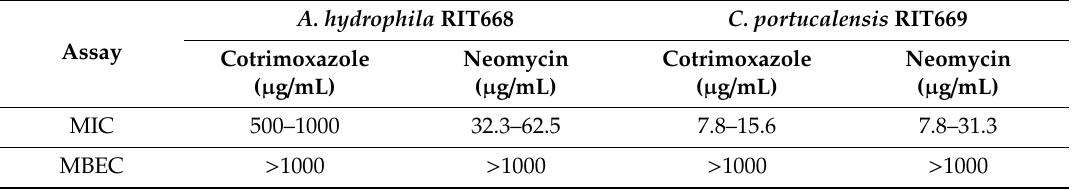
Table 4. Representation of the overall results of the MIC, MBC, and MBEC assay to evaluate the e ffi cacy of cotrimoxazole and neomycin sulfate on the two organisms, A. hydrophila and C. portucalensis . Inoculum = 10 6 CFU /